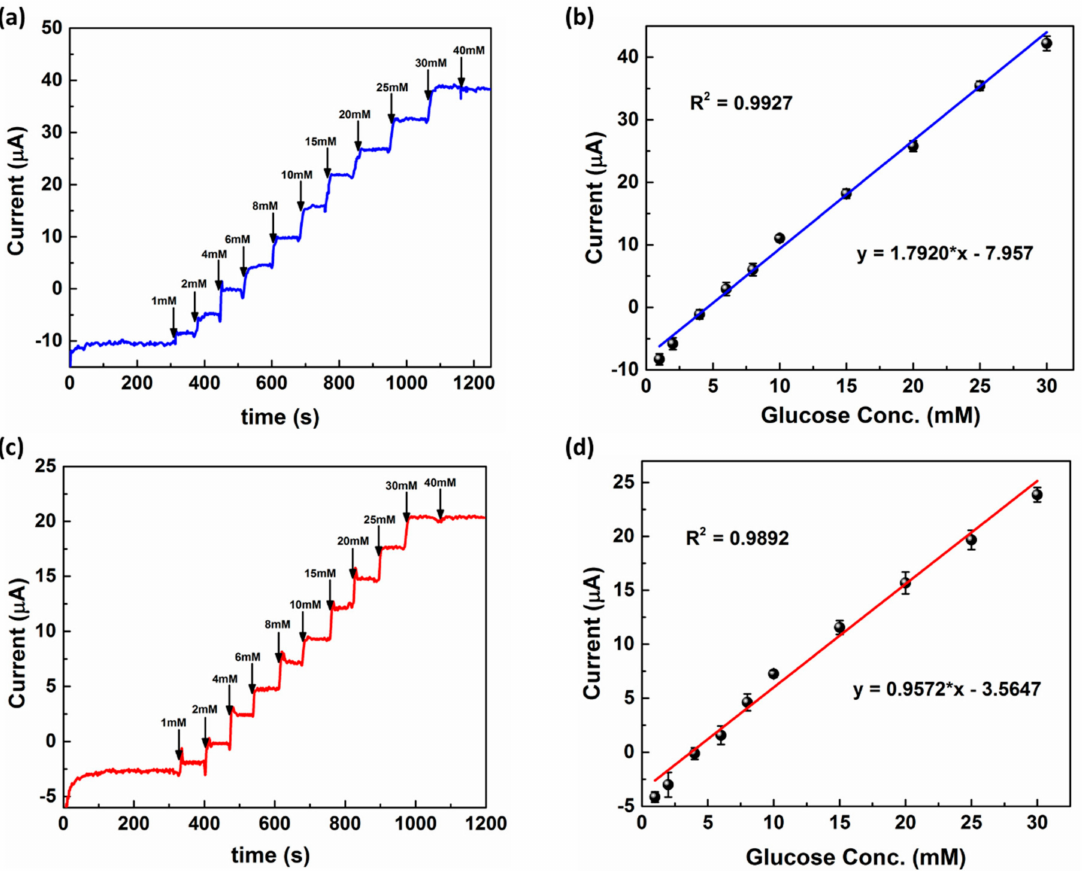
Figure 6. Chronoamperometric response curves (I vs. t) for the Au/Pt-black/Nf MNEAs in 10 × PBS and interstitial fluid (ISF), respectively, ( a , c ) with successive addition of various glucose concentrations (1–30 mM) at an applied external potential of +0.12 V vs. Pt-black CE/RE. Linear calibration plots for the glucose response curves in PBS and ISF, respectively, with linear regression equations ( b , d ). Each data point represents the average of three independent experimental values ( n = 3), with the range indicated in the standard error